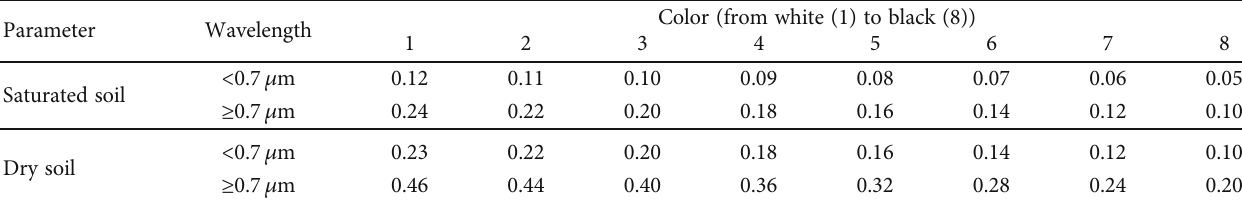
Table 1: Surface albedo of di ff erent surface types and water contents.